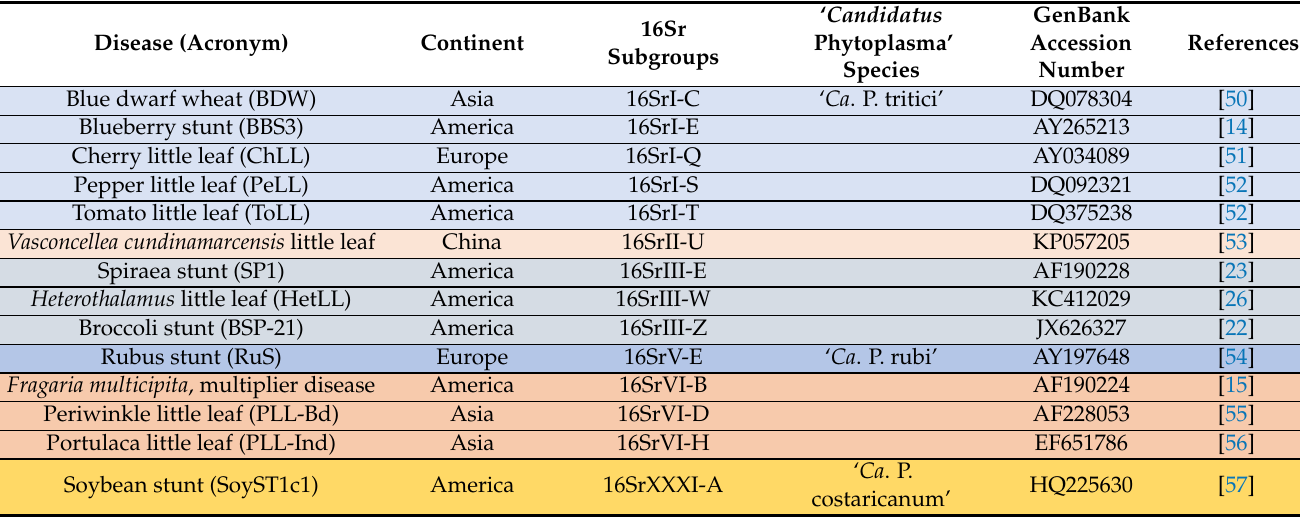
Table 2. Molecular diversity and geographic distribution of selected phytoplasmas belonging to different ribosomal groups/‘ Candidatus Phytoplasma’ species (marked by different color) associated with little leaf and stunting symptoms.